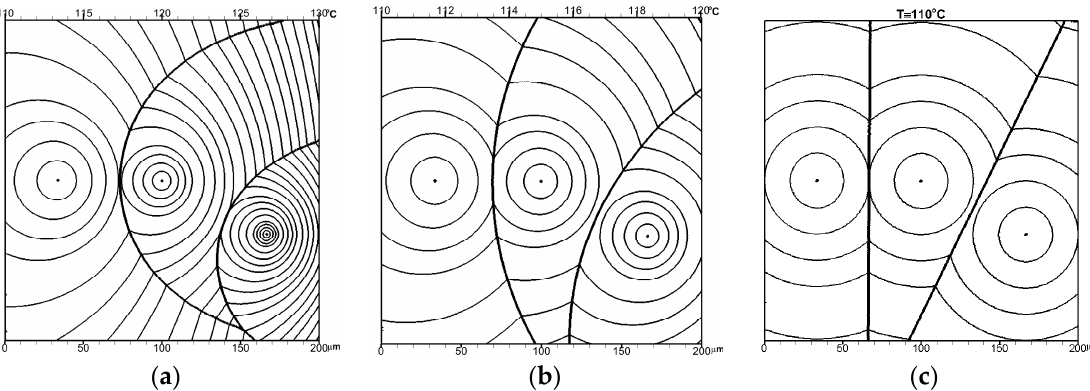
Figure 12. Shapes of interspherulitic boundaries predicted by the particle level set method for different temperature gradients: ( a ) °C·mm − 1 .